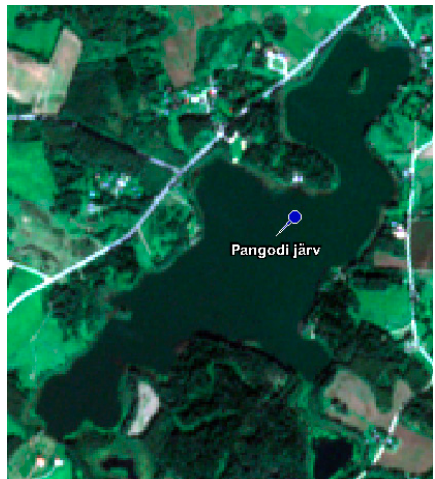
Figure A3. S2 MSI image of Pangodi from 28th of August 2016.